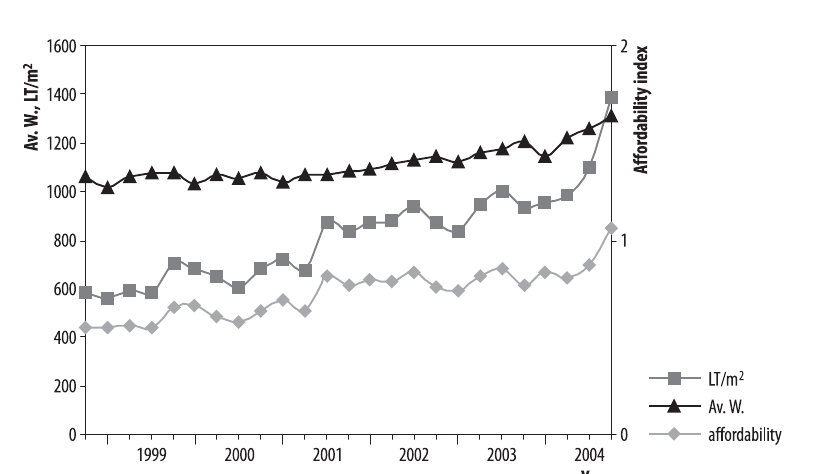
Figure 1. Average wages, average cost per m 2 and housing affordability index in Lithuania, 1998 Q4 – 2004